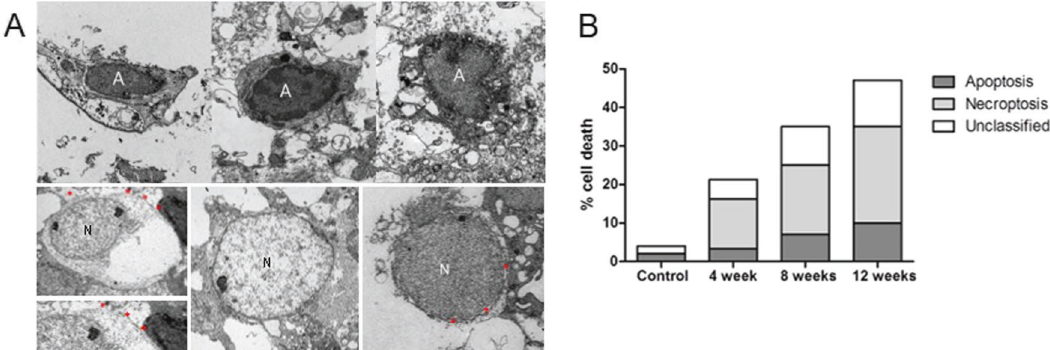
Fig. 4 Transmission electron microscopy (TEM) of retinal ganglion cells (RGCs). A Cells with condensed chromatin representing apoptosis were speci fi ed as A, and cells with perinuclear space dilation and decreased electron density in the cytoplasm representing necroptosis were speci fi ed as N. B Discontinuous cell membrane (red asterisks), electron-lucent nucleus, and perinuclear space dilation (red asterisks) are observed in cells representing necroptosis. As the proportion of dying RGCs increased after systemic hypotension, the proportion of necroptotic cells increased. For TEM analysis, n = 6 for control and n = 6 for systemic hypotension at each time period; total n =